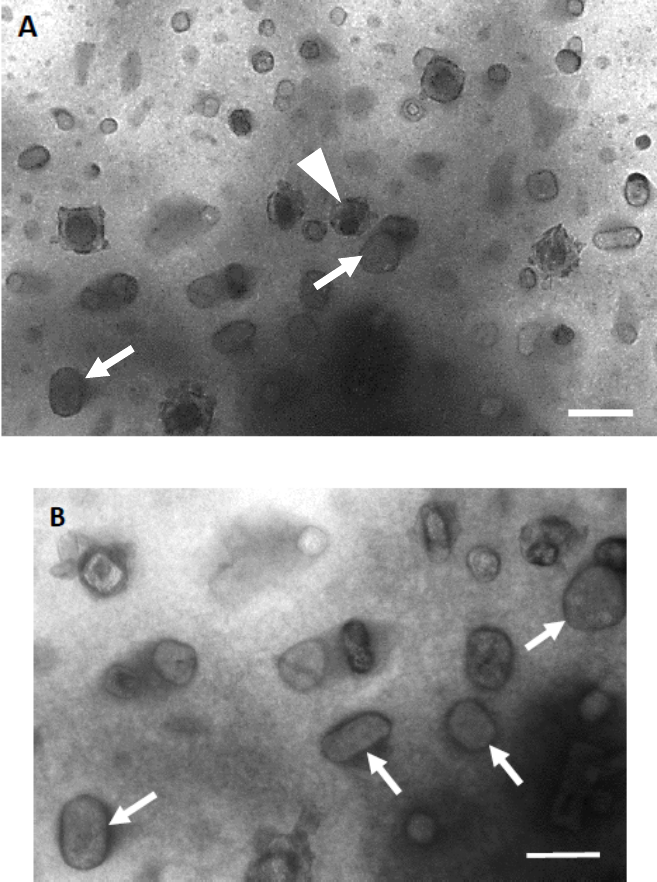
Figure 3. Negative staining electron micrographs of isolated platelet granules in the microchip. ( A ) There are many types of isolated platelet granules with different sizes in the micrograph. The boundary of isolated platelet granules was black after negative staining. Among them, α -granules are large and round or oval in shape, with homogeneous gray content (indicated by white arrows). A dense granule with a high-density core surrounded by a stain-free rim was also identified (indicated by a white arrowhead). The small circular vesicles with low electron density and whitish-gray in color are lysosomes or exosomes. Some broken granules could also be observed. ( B ) The negative stained granules was shown in higher magnification. The α -granules (indicated by white arrows) could be identified with a long axis length of about 200 nm. Scale bar, 0.2 μ m.